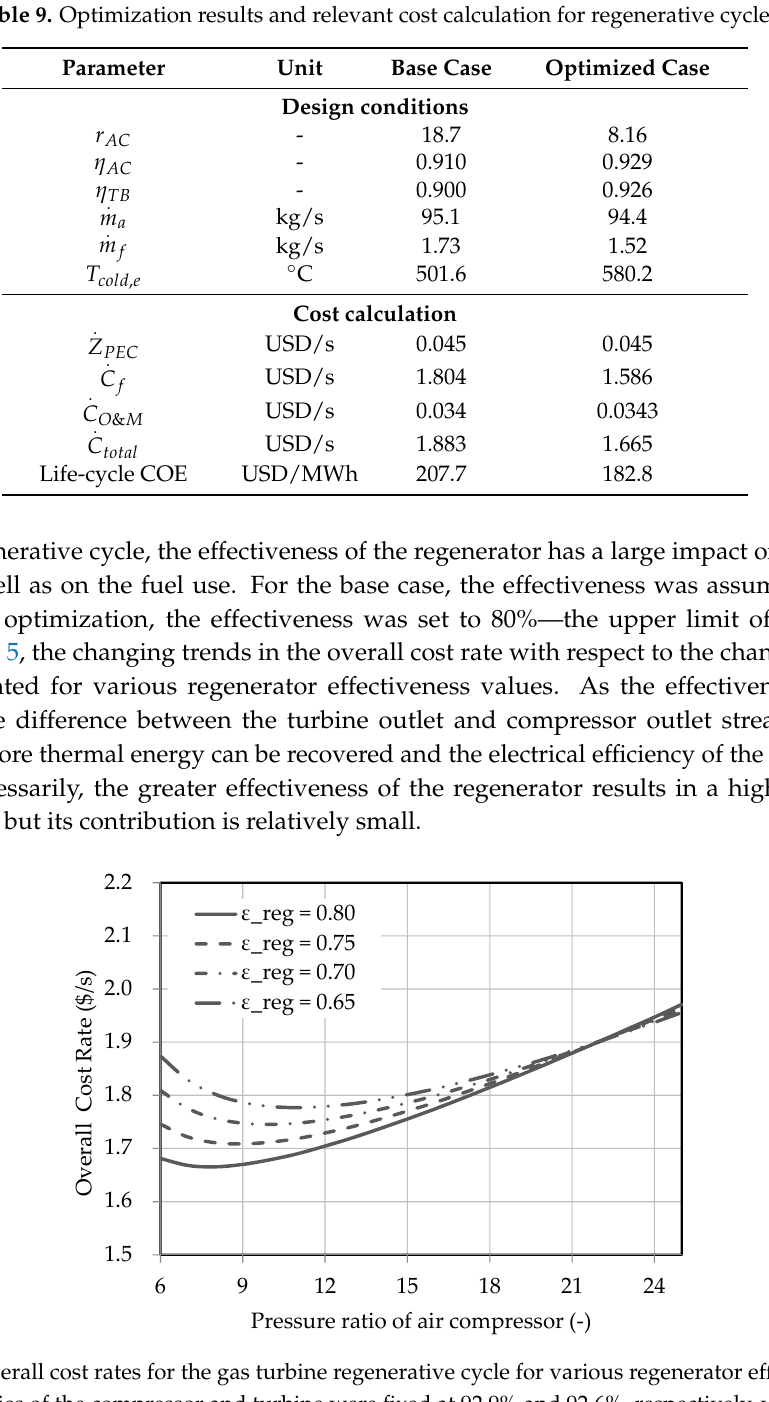
Table 9. Optimization results and relevant cost calculation for regenerative cycle.